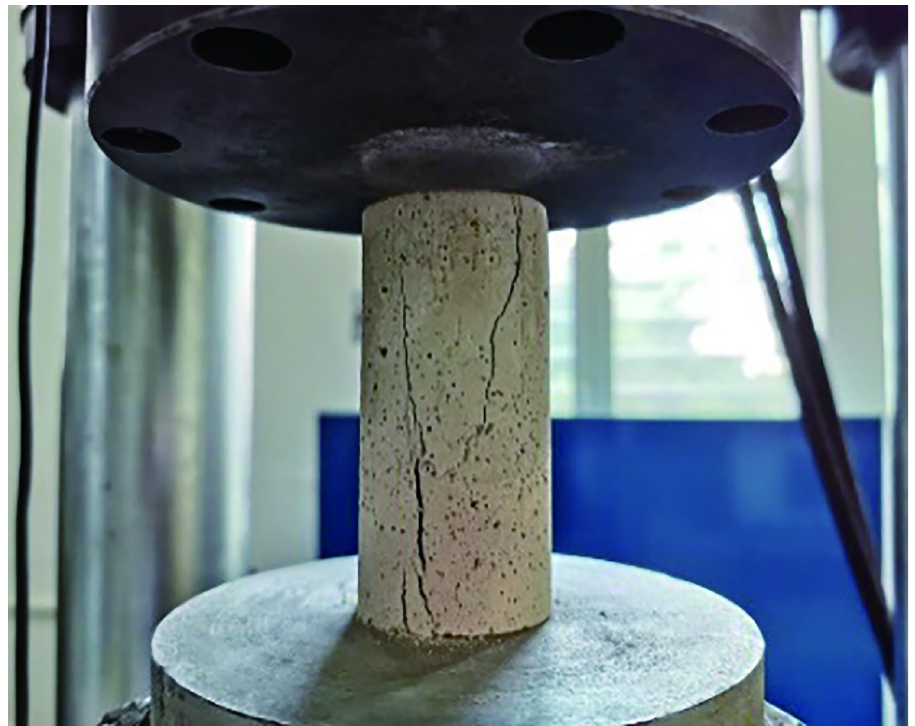
Fig 3. Compressive strength test for rockburst-like